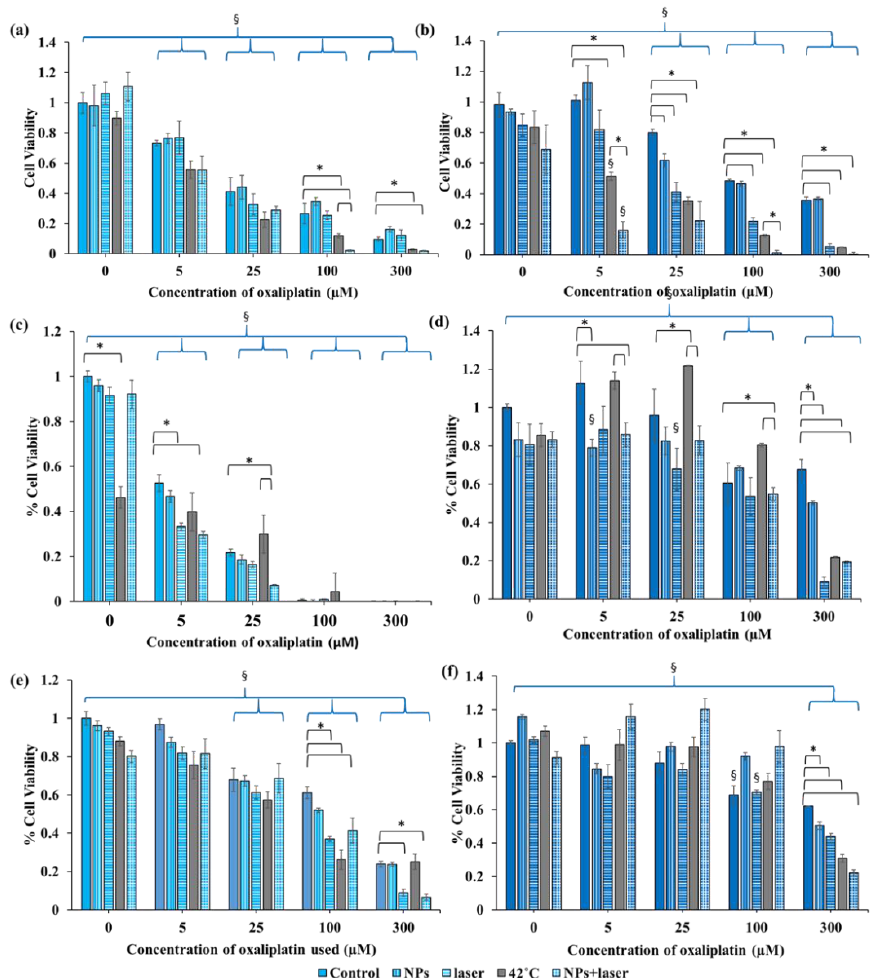
Figure 8. Cell viability of ( a ) OxS CT-26, ( b ) OxR CT-26, ( c ) OxS RKO, ( d ) OxR RKO, ( e ) OxS HT-29 and ( f ) OxR HT-29 cells measured 24 h after a two hour exposure to increasing concentrations of oxaliplatin and temperatures of 37 or 42 °C for two hours, compared to 42 °C induced using laser stimulation of the VMWNPs. * Indicates statistical differences between the groups and § indicates statistical differences between the treatment group and the untreated control ( p < 0.05).